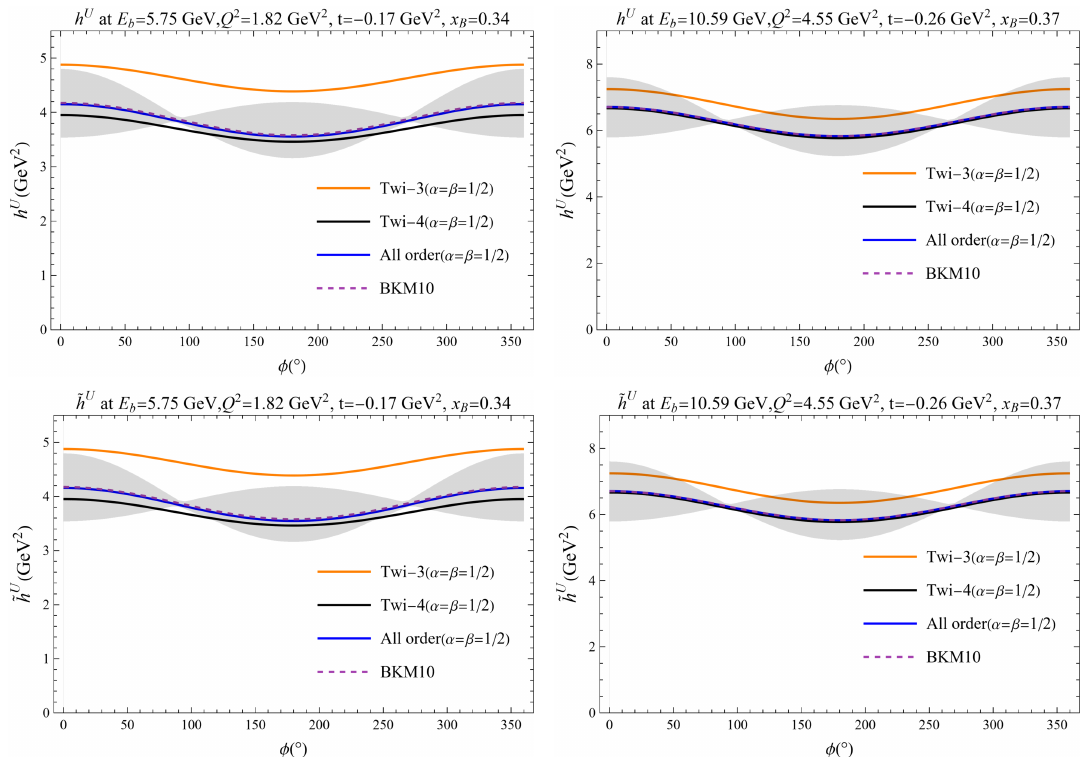
Figure 4 . Comparison of the coefficients h U and ˜ h U from light cone calculation with the BKM10 result. The orange line stands for the results with only twist-three kinematical accuracy, the black line has twist-four kinematical accuracy, while the blue line contains kinematics of all order. The dashed line is the BKM10 result. The gray band consists of all possible values of those coefficients with 0 ≤ α ≤ 1 and 0 ≤ β ≤ 2 .